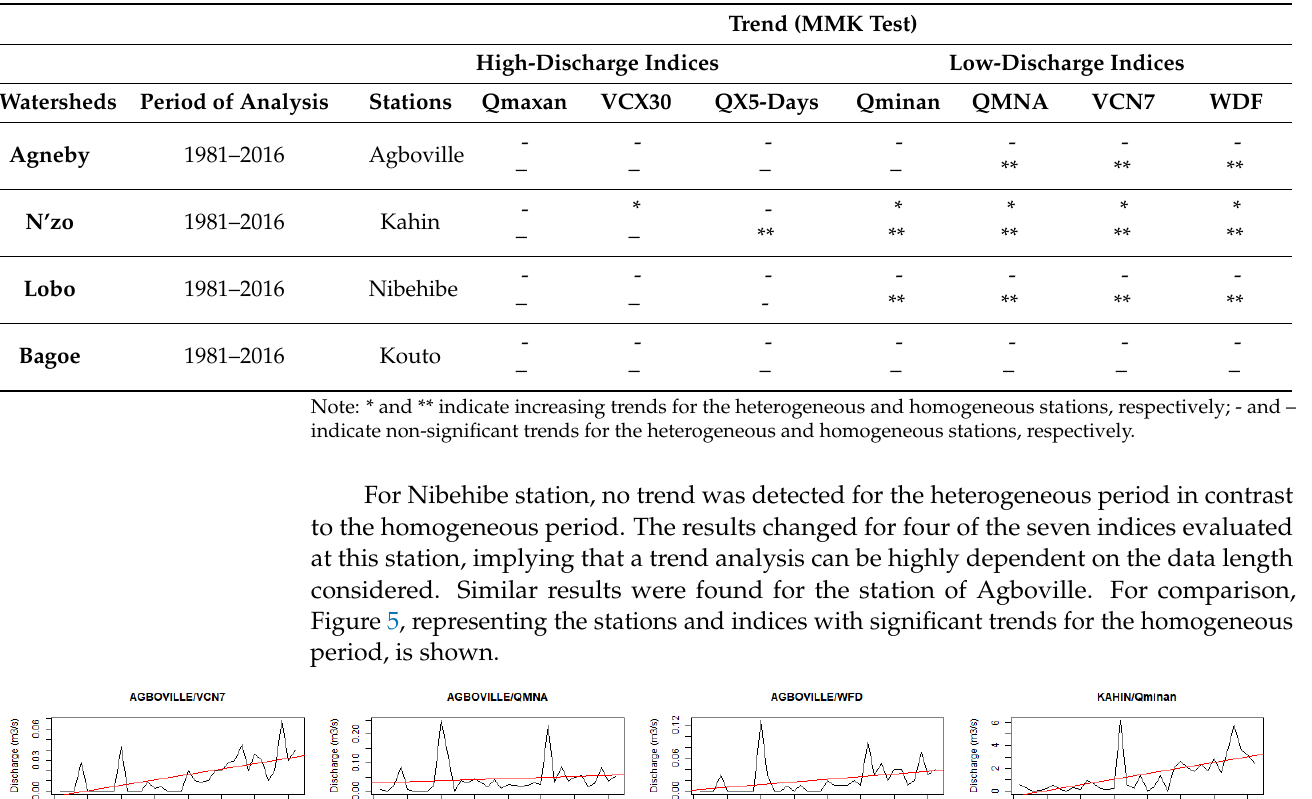
Table 5. A trend analysis for the heterogeneous and homogeneous stations of flood and low-discharge indices in some watersheds in C ô te d’Ivoire.